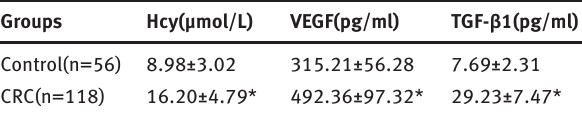
Table 2: The serum Hcy VEGF and TGF-β1 of CRC and